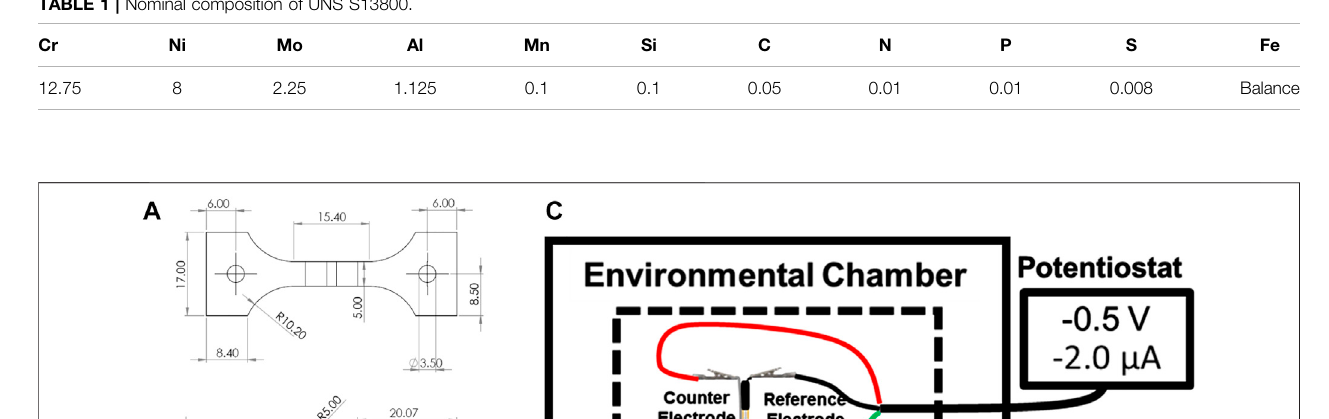
Frontiers in Chemistry |